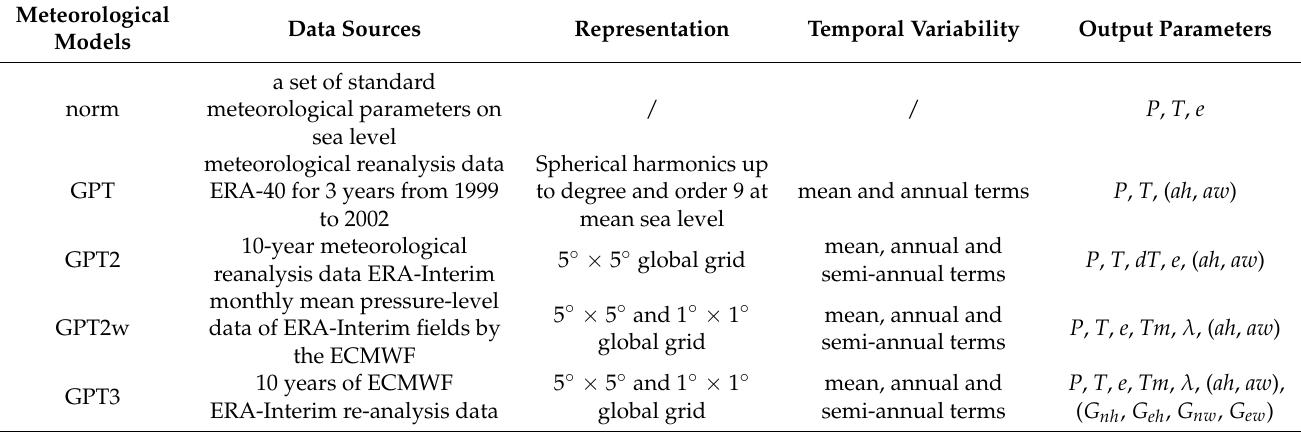
Table 1. Primary information of five meteorological models. ( P —pressure, T —temperature, e -water vapor pressure, dT — lapse rate, Tm —mean temperature weighted with water vapor pressure, λ —water vapor decrease factor, ah , aw —mapping function coefficients, G nh , G eh , G nw , G ew —gradient, GPT—Global Pressure and Temperature, ECMWF—European Center for Medium-Range Weather